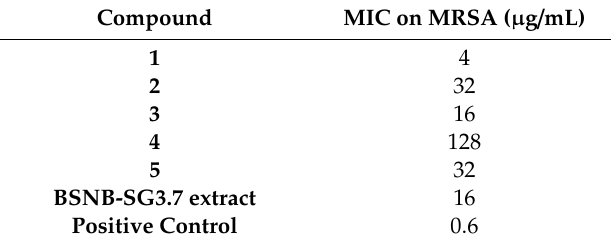
Table 1. Antimicrobial activities of compounds